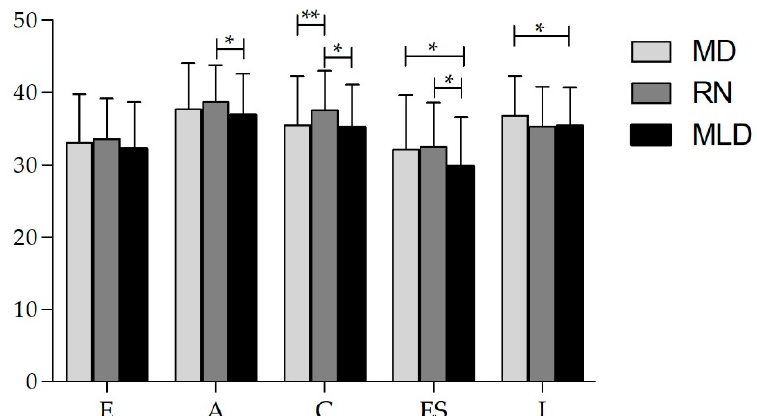
Figure 1. Personality dimensions of IPIP Big-Five (mean ± SD) within different majors (ANCOVA